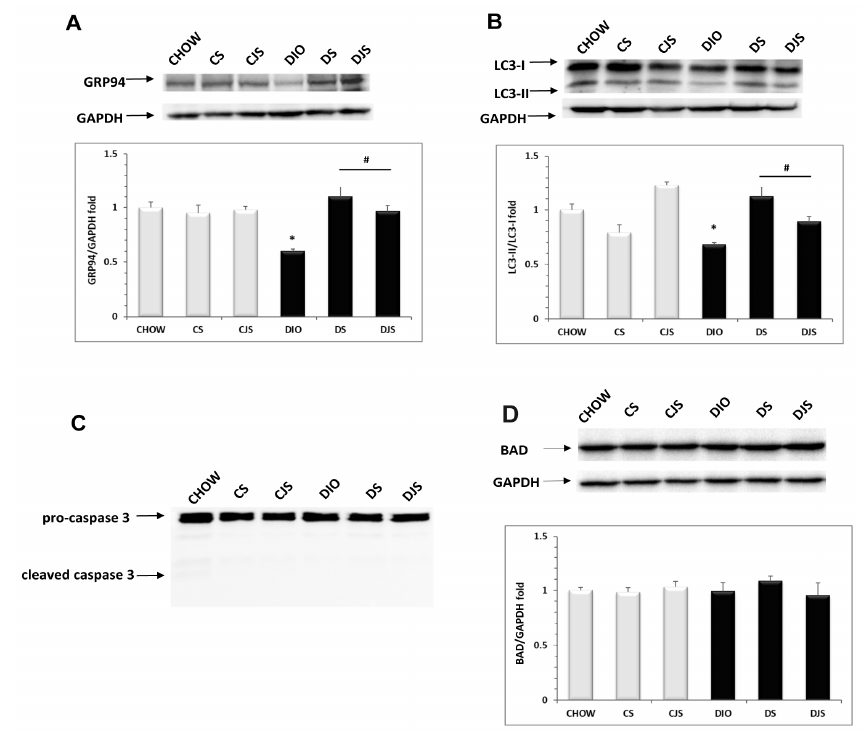
Figure 8. Lysates of liver from all of the animal groups were immunoblotted using specific antibodies, namely: ( A ) anti-GRP94 molecular weight 100 KDa; ( B ) anti-LC3 that recognized the isoform at 16 KDa (LC3-I) and 14 KDa (LC3-II); ( C ) anti-caspase 3 that revealed the pro-caspase 3 at 31 KDa and cleaved caspase 3 at 17 KDa; and ( D ) anti-BAD that revealed a band at 20 KDa. Values indicate the densitometric analysis using CHOW rats as the control. GAPDH levels were used as the loading control. Blots are representative of three separate experiments. The LC3-II / LC3-I ratios were calculated after densitometric analysis. CHOW—control rats with standard diet; CS—CHOW plus tart cherry